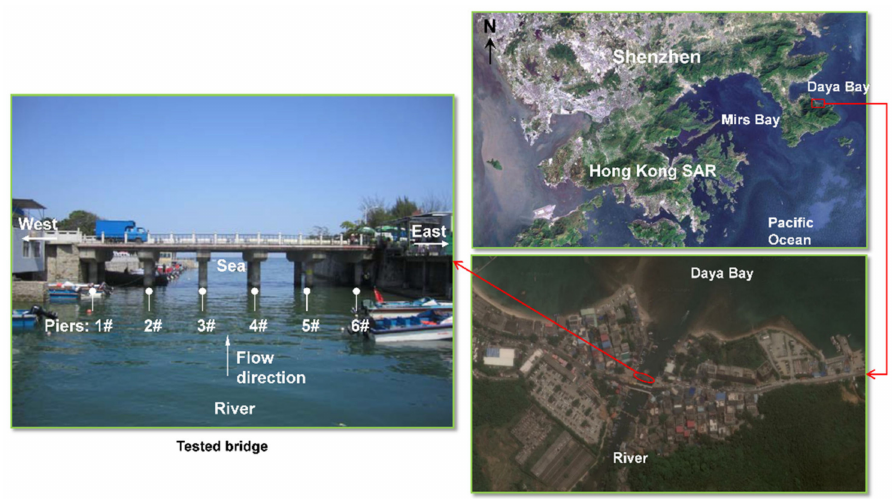
Figure 1. Geographic location of The tested bridge.